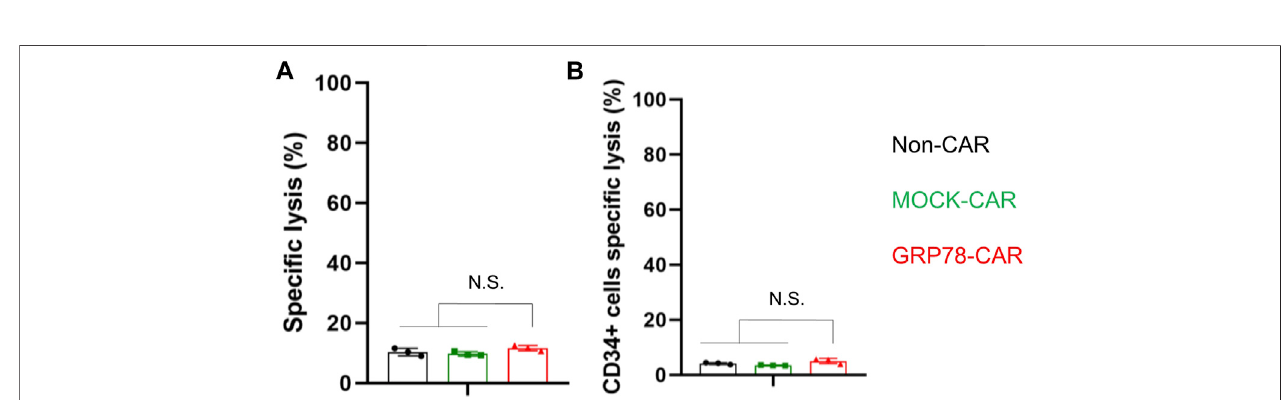
FIGURE4| Hematopoieticstemcellsarespared byglucose-regulatedprotein78(GRP78) – chimericantigenreceptor(CAR)Tcells. (A) cytotoxicassaymeasuring the speci fi c lysis of bone marrow cells from healthy donors. CFSE-labeled primary normal bone marrow cells were co-incubated with Non-CAR T, MOCK-CAR T, and GRP78-CARTcellsataneffector/targetratioof5:1for24 h.Experimentswererepeatedwithatleasttriplicatewells.Datarepresentmeans±SDs.*** p < 0.01(two-sided Student ’ s t-test). (B) cytotoxicity of Non-CAR, MOCK-CAR, and GRP78-CAR T cells against hematopoietic stem cells (CD34 + ) derived from the bone marrow of healthydonors.Thecellswereco-culturedataneffector/targetratioof5:1for24 h.Datarepresentmeanvaluesoftriplicatewells±SDs.*** p < 0.01(two-sidedStudent ’ s t-test).